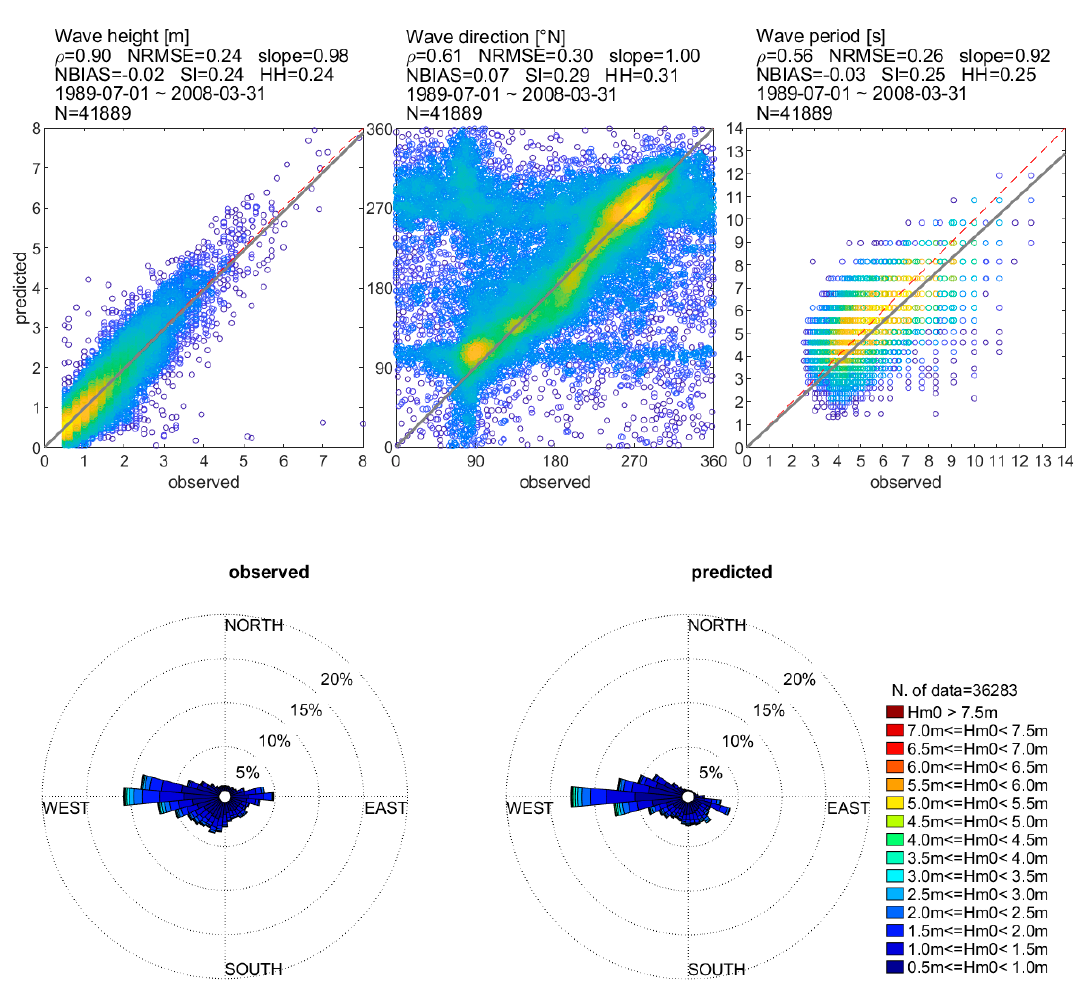
Figure 3. Wave data at the Ponza buoy. On the top is a comparison between observed and predicted significant wave height, mean wave direction, and mean wave period. At the bottom are observed ( left ) and predicted ( right ) wave climate in terms of wave roses.